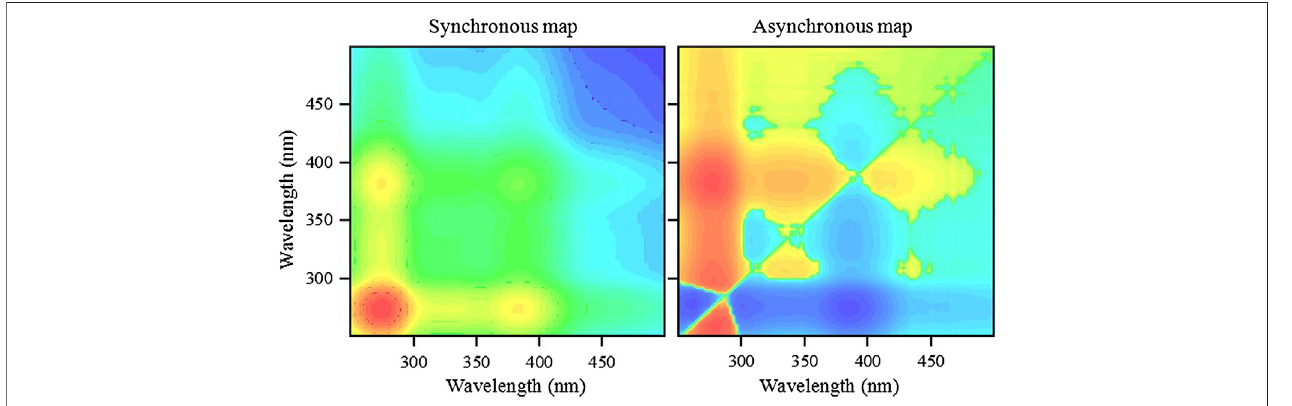
FIGURE 4 | Asynchronous and synchronous maps of 2D-COS of DOM-Cu(II) obtained by the 1/9-th power transformation. The red regions show positive correlations, and the blue regions show negative correlations. An increase in the intensity of a particular color represents a stronger positive or negative